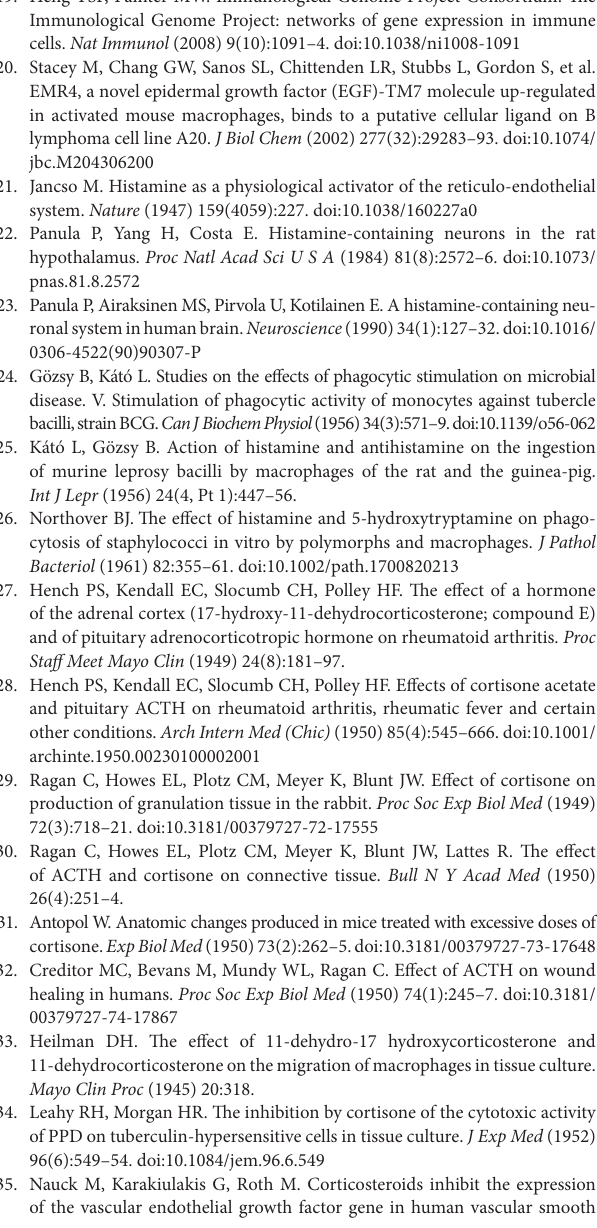
FiGURe S1 | Monocytes and macrophages express many neuroendocrine- related genes. Gene expression of selected neurotransmitters and hormone receptors (columns) in distinct monocyte and macrophage populations (rows) distributed throughout the body. The ImmGen dataset was plotted as heatmap with hierarchical clustering as described by Beyer et al. (162), using a coefficient of variation of 20%. Levels of expression are represented by colors in which red, white, and blue indicate high, intermediate, and low intensities,